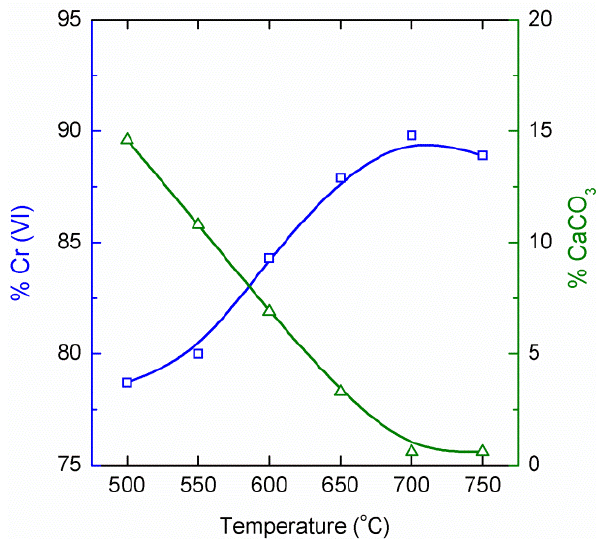
Figure 3. Correlation of Cr(VI) content with the percentage of the CaCO 3 content.